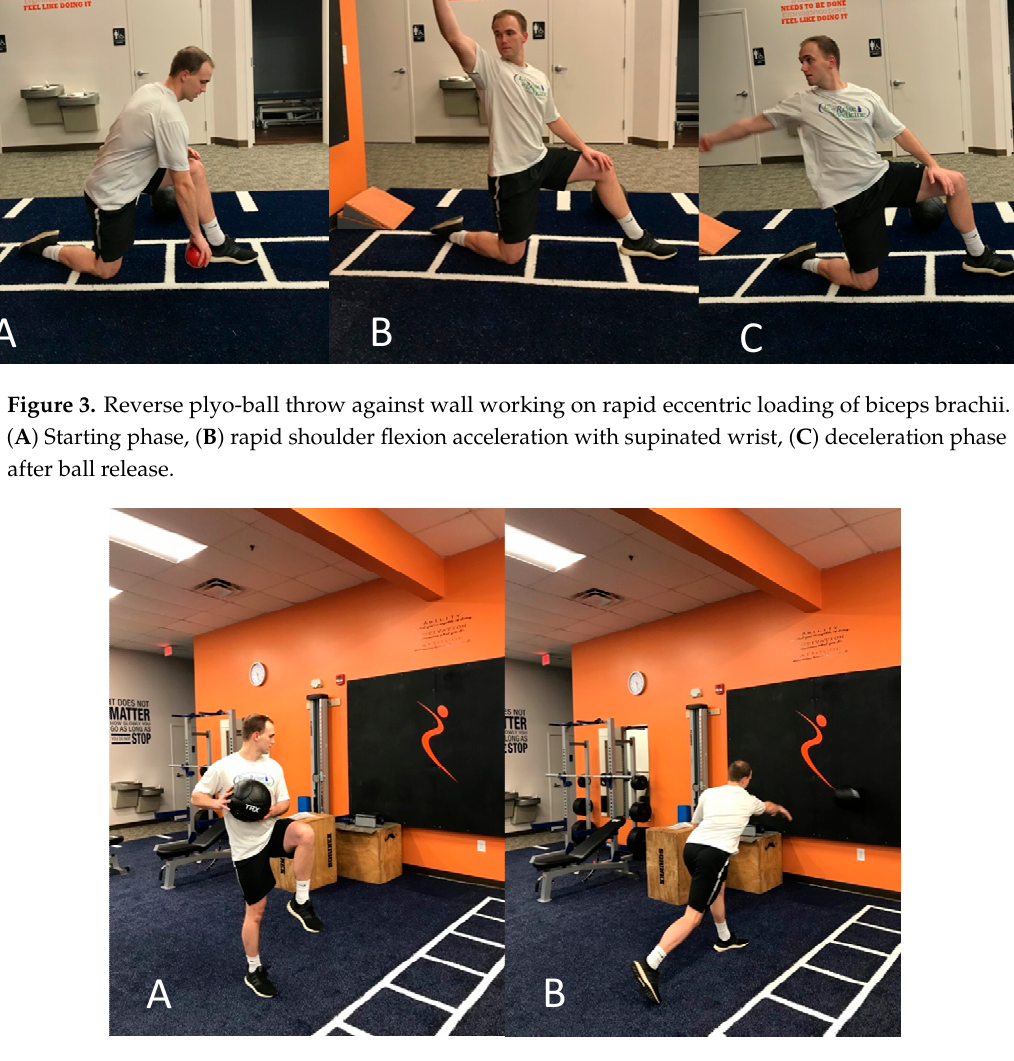
Figure 5. Rapid eccentric biceps brachii loading using wrist weights. ( A ) Starting position in elbow flexion and wrist supination, ( B ) end position after rapid elbow extension and wrist pronation into follow-through phase. 2.8. Outcomes The patient was seen in PT five times, including the initial evaluation, over the course of four weeks. Subjective and objective reassessment measures were completed at the beginning and end of each session, with outcomes presented in Table 3. FOTO was used on the initial evaluation and discharge. The Patient’s Physical FS Primary Measure score intake improved from 83 to 98 points and demonstrated 15 points of change. Given the patient’s risk-adjustment variables and the actual intake FS score, FOTO predicted that the patient will increase in function by at least 8 points (to 91), suggesting his minimal clinically important difference (MCID) was satisfied. NPRS and GROC both improved greater than their respective MCIDs. MMT was normal and pain free, and he no longer had tenderness or pain with provocative testing. The patient was contacted via email six weeks after discharge. He reported that he did not have any residual pain or loss of function related to his elbow. He returned to pain-free throwing and was satisfied with his improvement.